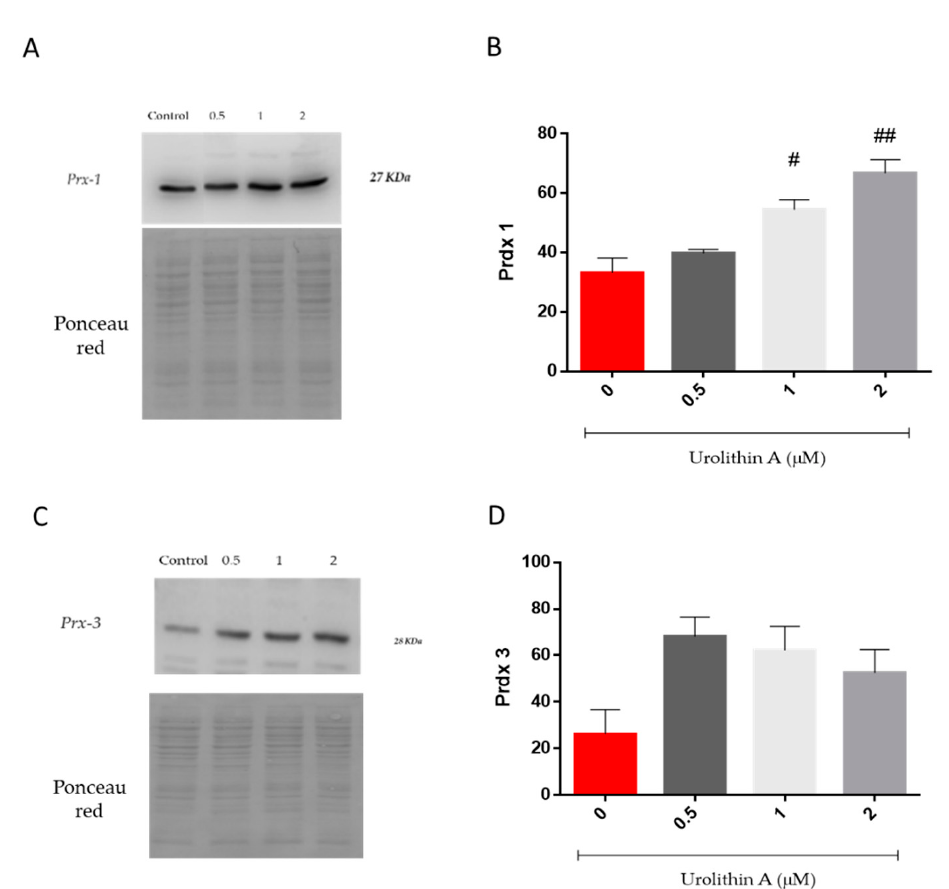
Figure 6. Urolithin A-induced cytoprotection of Neuro-2a cells is mediated by induction of peroxiredoxin 1 and 3 (Prx1, Prx3). Prx 1 ( A , B ) and Prx 3 ( C , D ) expressions were determined by Western blot in 10 μ g of protein extract and expressed as Prx densitometry. Ponceau red staining of membranes prior to blotting was performed to further check protein transfer and loading. Note: # p < 0.05 versus Control; ## p < 0.01 versus Control